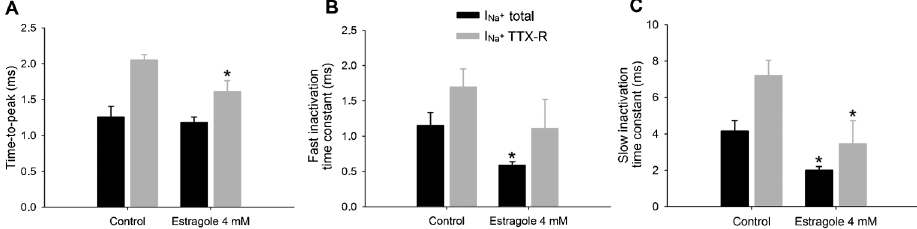
Figure 4. Effects of 4 mM estragole on kinetic parameters of total (INa + total) and tetrodotoxin-resistant (INa + TTX-R) Na + current. Panel A shows time-to-peak parameter and panels B and C show fast and slow inactivation time constants. Data are reported as means±SE for n=5-6. *P , 0.05, statistical difference of 4 mM estragole effects on INa + total or INa + TTX-R compared to control (Student t